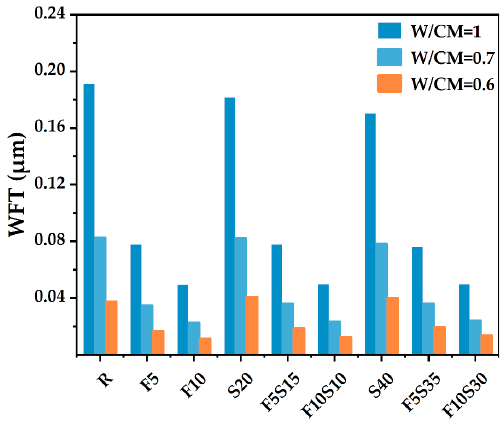
Figure 7. The calculated water film thickness in relation to the W/CM ratios and